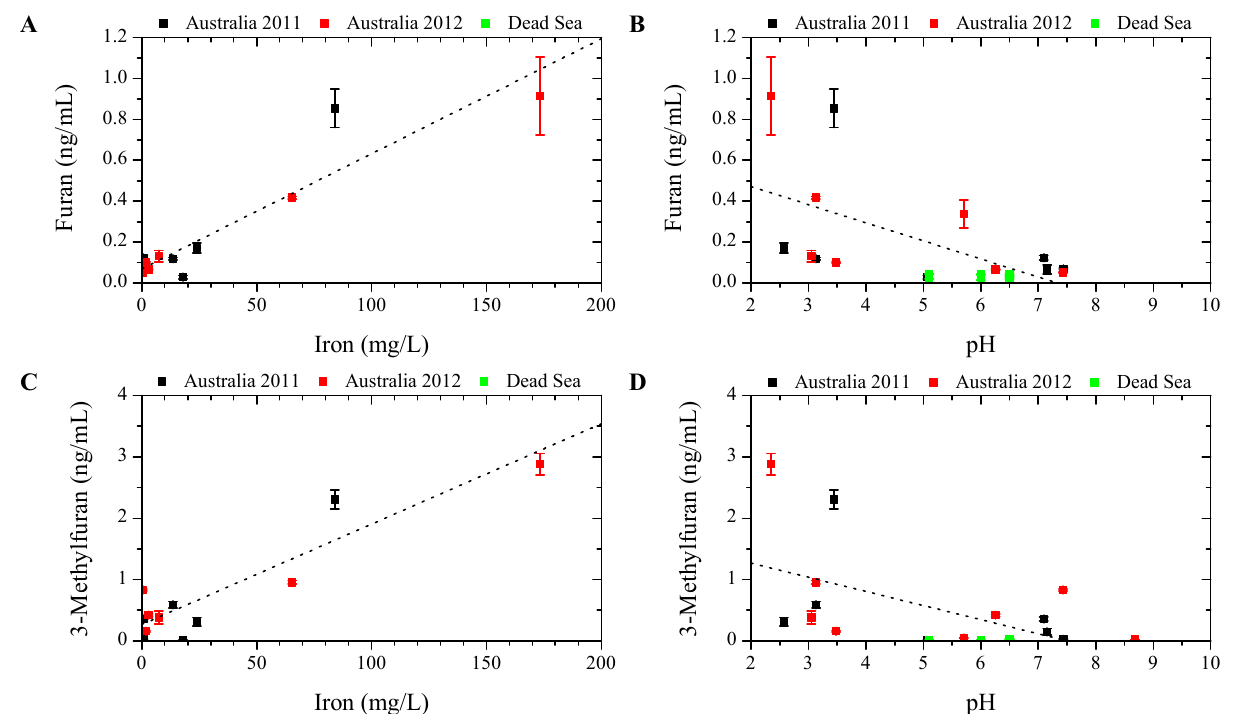
Figure 9. Furan emissions dependent on (A) iron concentration, (B) pH and (C) organic carbon content in water samples (Australia 2011: black; Australia 2012: red; Dead Sea 2012: blue). Data points represent mean values with error bars indicating standard deviations from triplicate